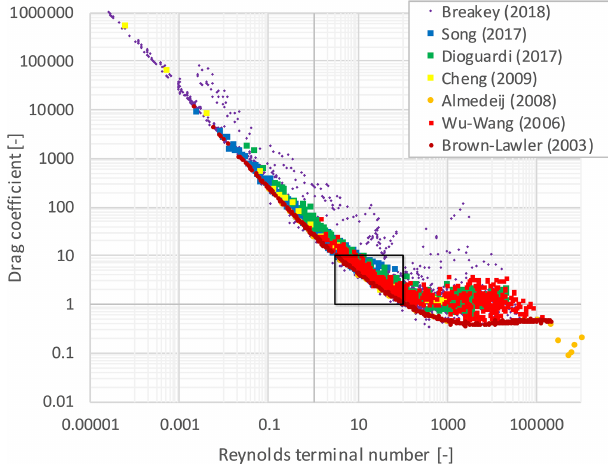
Figure 11. SDC (log–log) data from the sources in the literature.